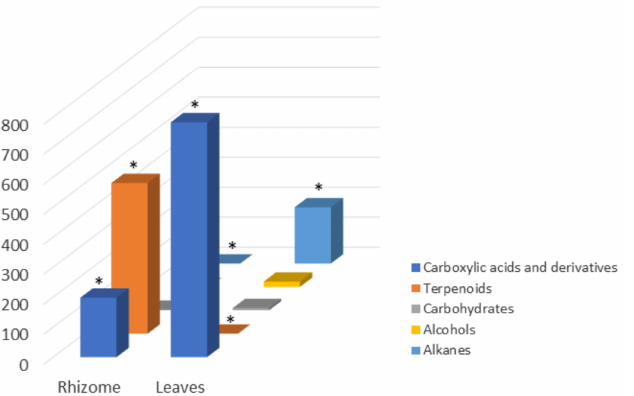
Figure 2. Graphical presentation of the total amount of each class of compounds for the two studied plant parts. * Statistically different (Tukey’s test) p <